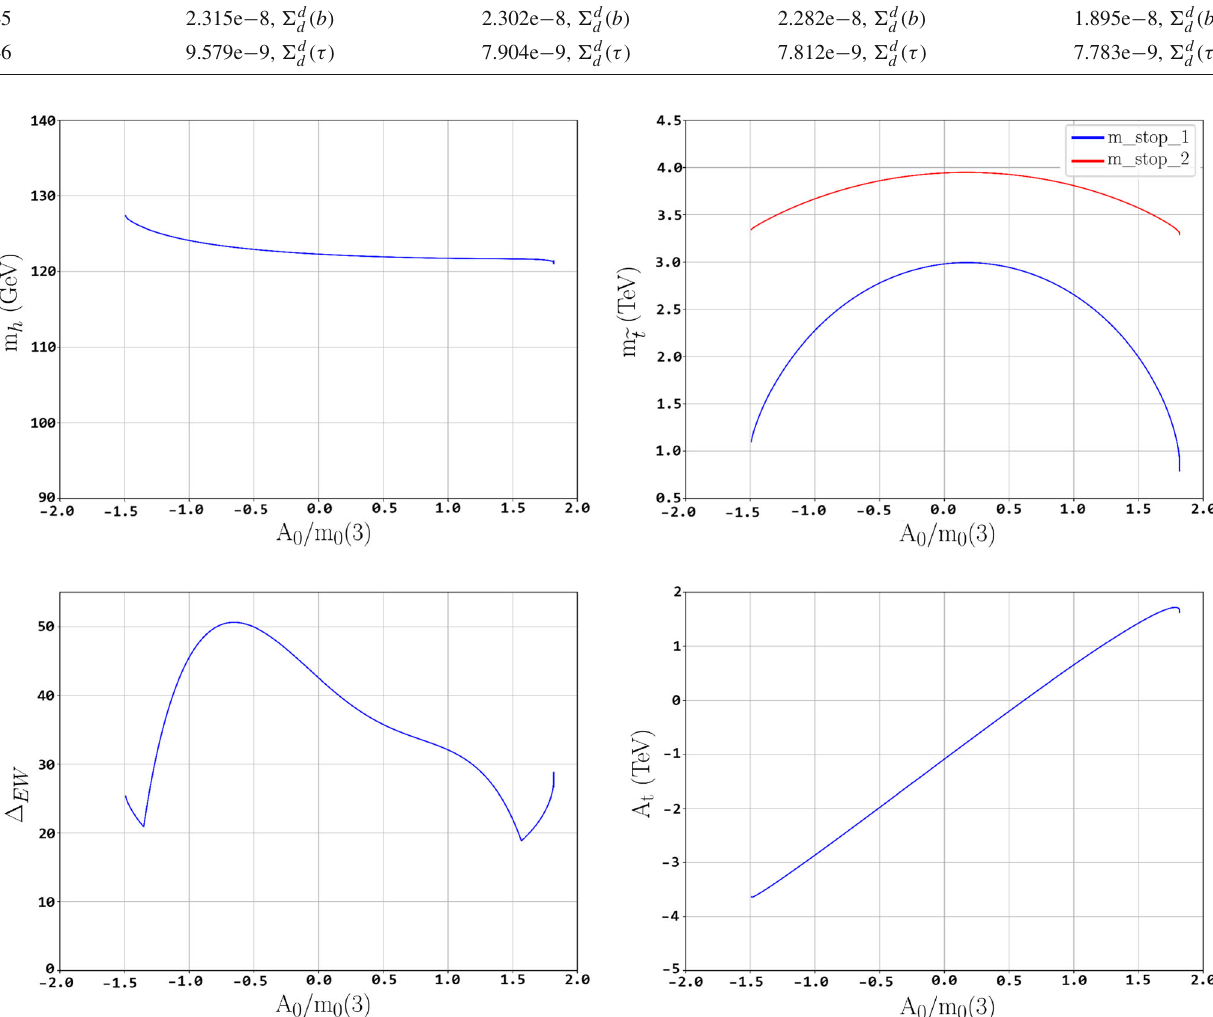
Fig. 2 Values of a m h , b m ˜ t , c (cid:2) EW and d A t ( Q ) vs. A 0 / m 0 ( 3 ) for the NUHM3 model with m 0 ( 1 , 2 ) = 10 TeV, m 0 ( 3 ) = 5 TeV, m 1 / 2 = 0 . 7 1 , 2 TeV, tan β = 10 with μ = 200 GeV and m A = 2